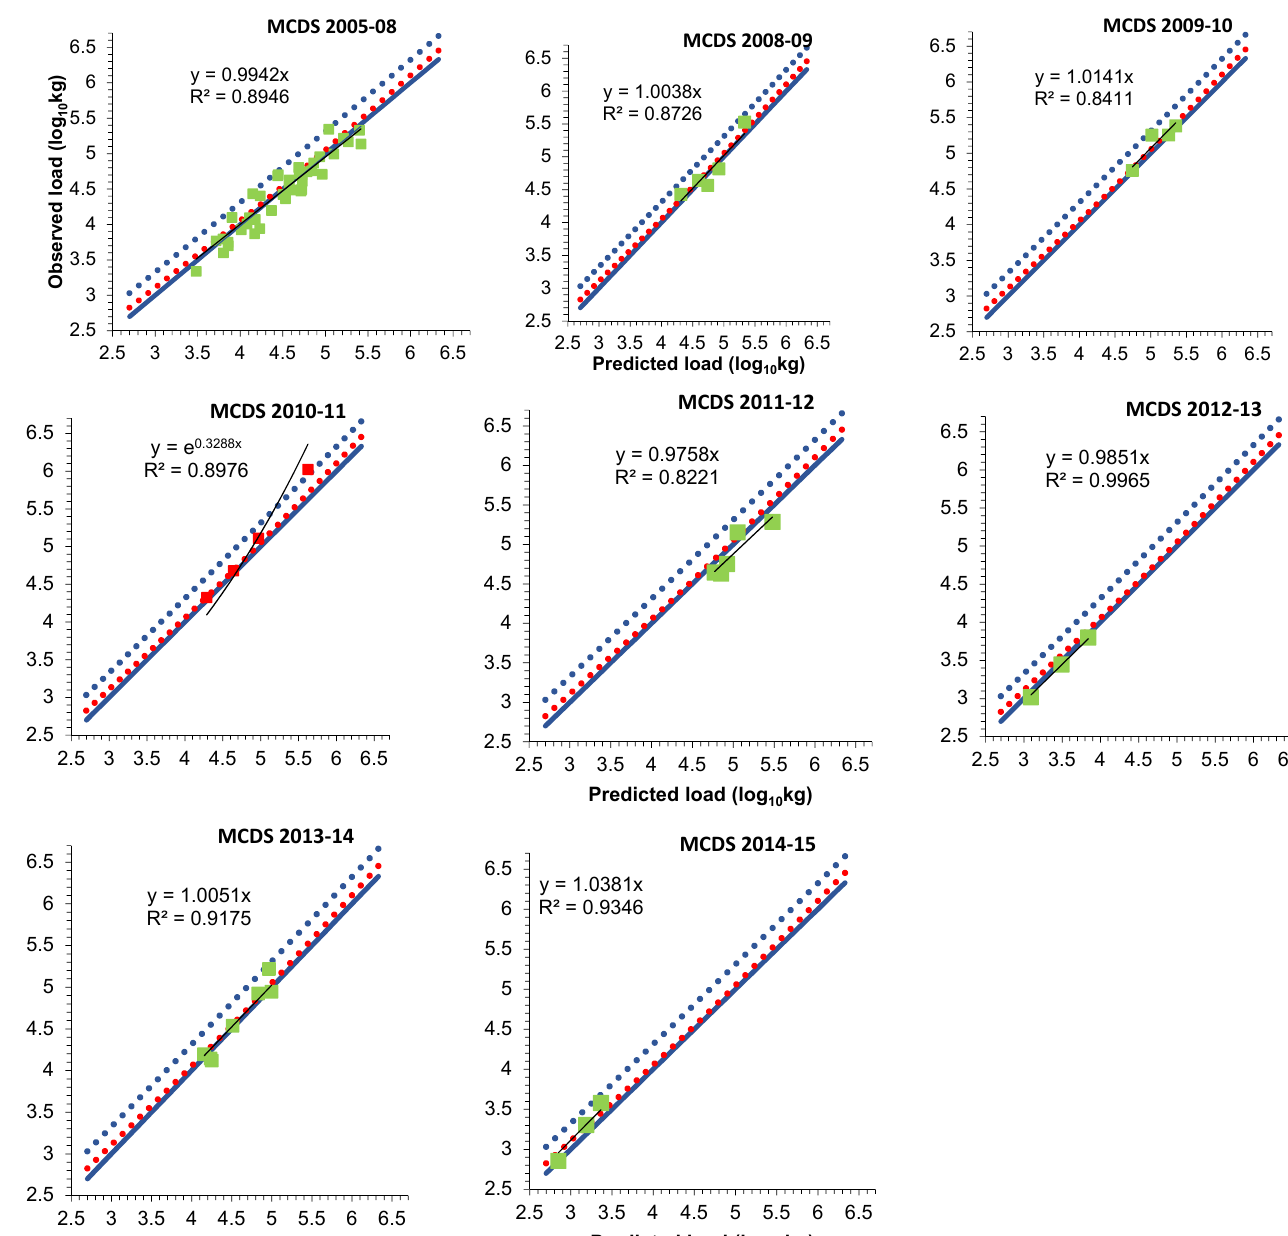
Figure A2. Relationship between OTL and PTL at GCDS (2005–2015).